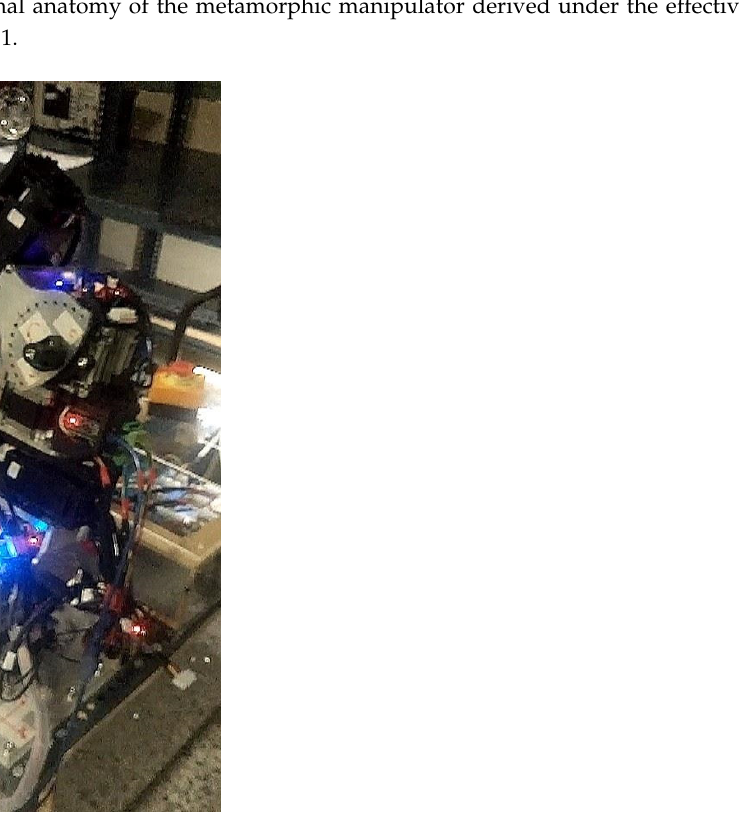
Figure 12. Optimal anatomy of the metamorphic manipulator derived under the MMA measure for Task 1.